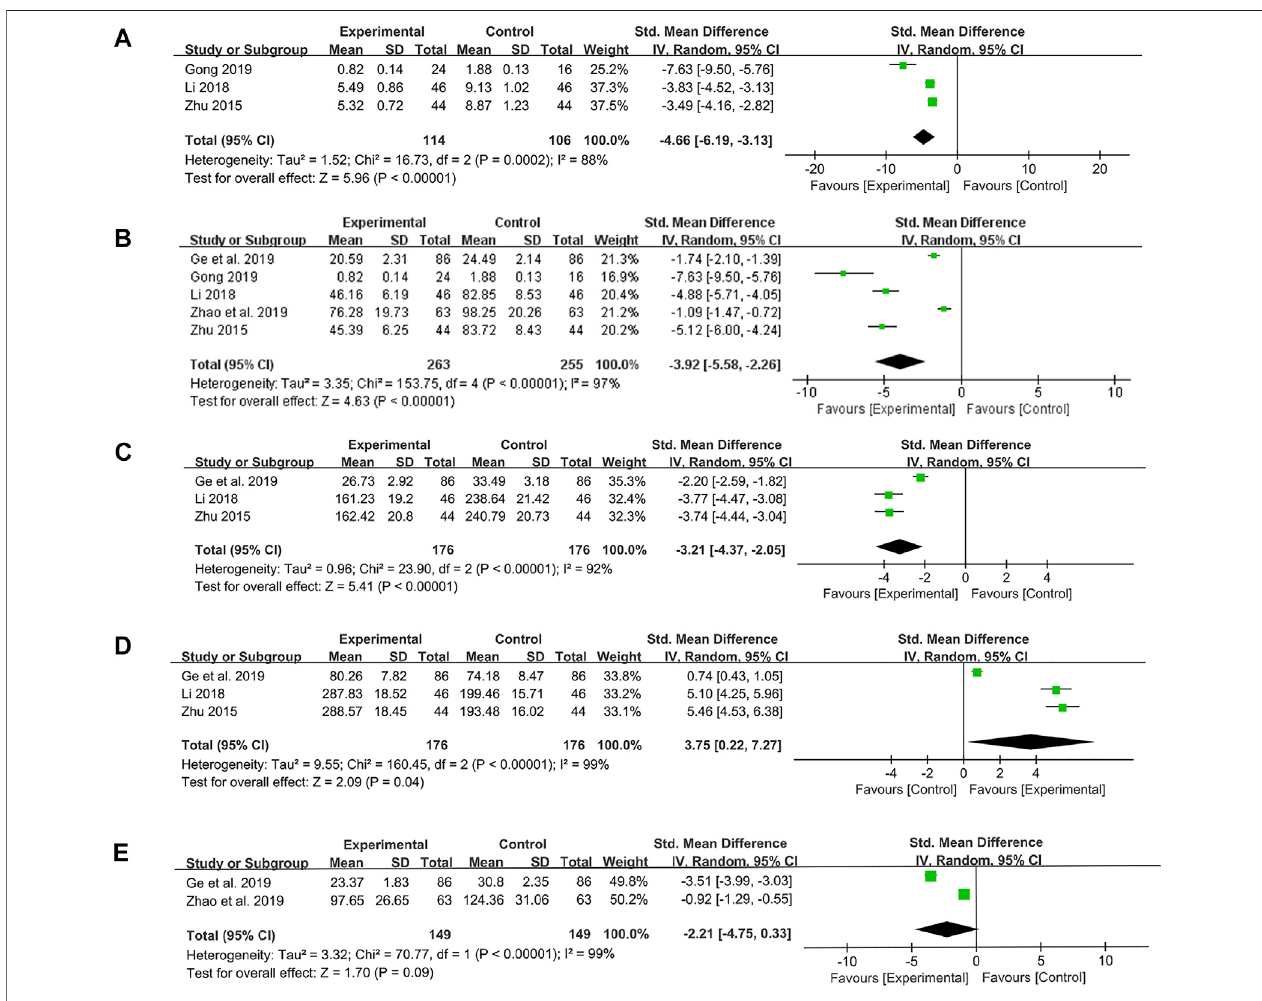
FIGURE7| Forestplotdisplaying theresultsofthemeta-analysisforin fl ammation-related proteins and cytokines. (A) Theresults ofCRP. (B) Theresults ofTNF- α . (C) The results of IL-8. (D) The results of IL-10. (E) The results of IL-6.